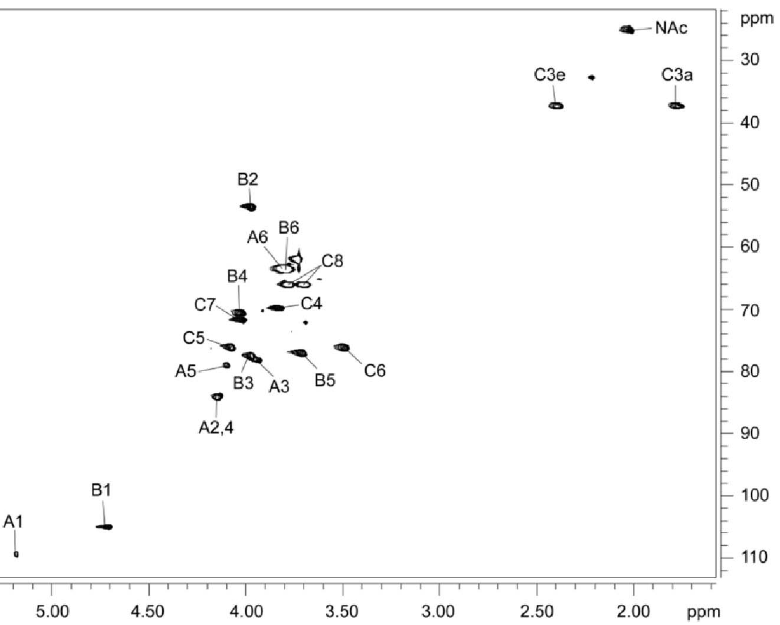
Figure 3. 2-D HSQC NMR spectrum of the polysaccharide with assignments of all the signals of the three major residues. For numbering, see Table 3.